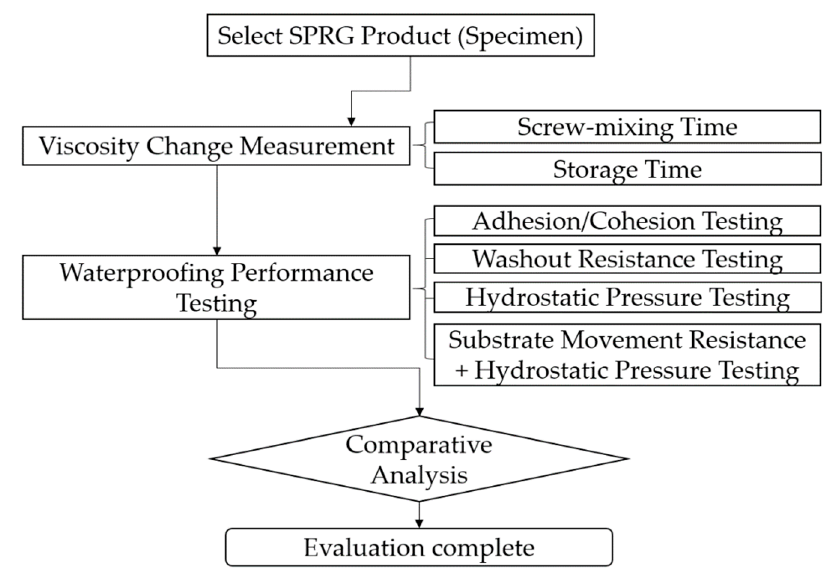
Figure 6. Evaluation procedure flow chart.